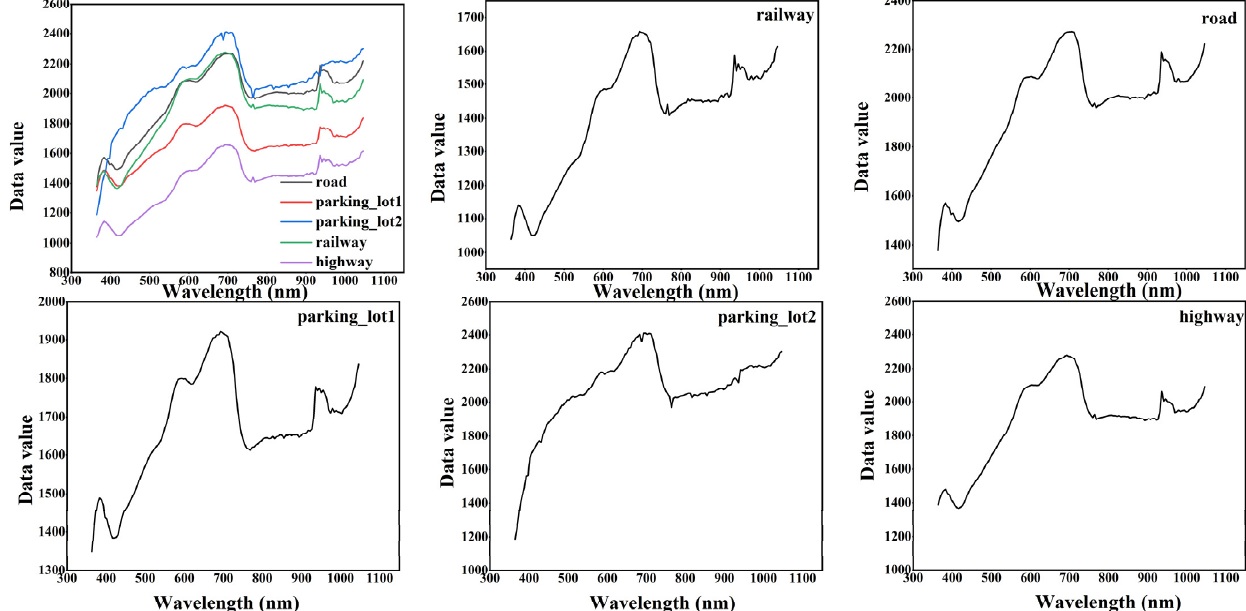
Figure 9. Spectral curves of classes with commission and omission error on Houston dataset.